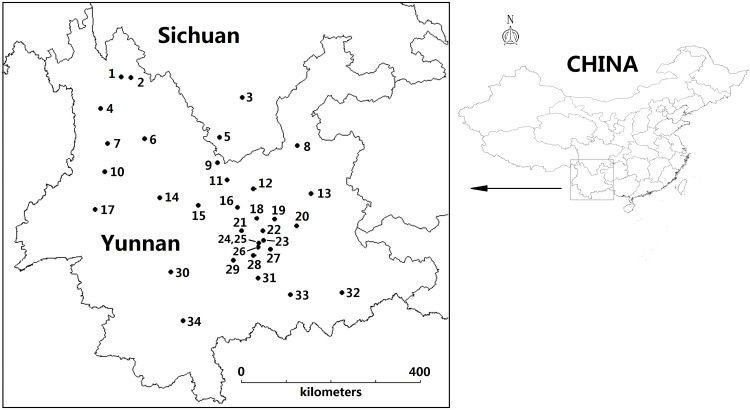
Localization of the sampling sites (1–34; for details see in Table 1).The figure was created by DIVA-GIS 7.5 software.